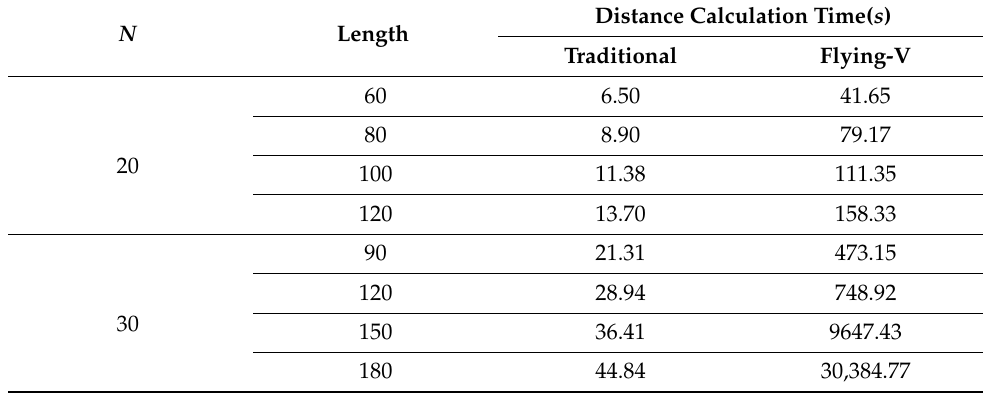
Table 4. Running time comparison.